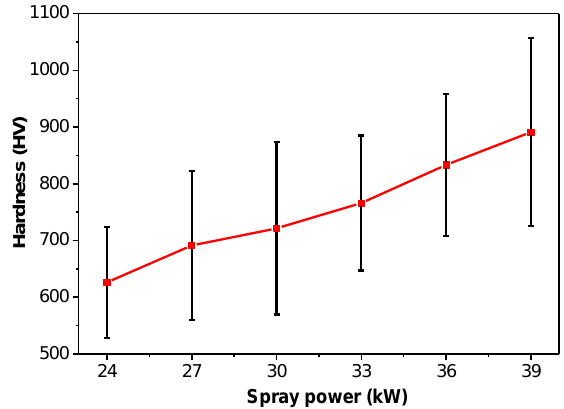
Spray power (kW) Figure 10. Hardness at different spray powers.